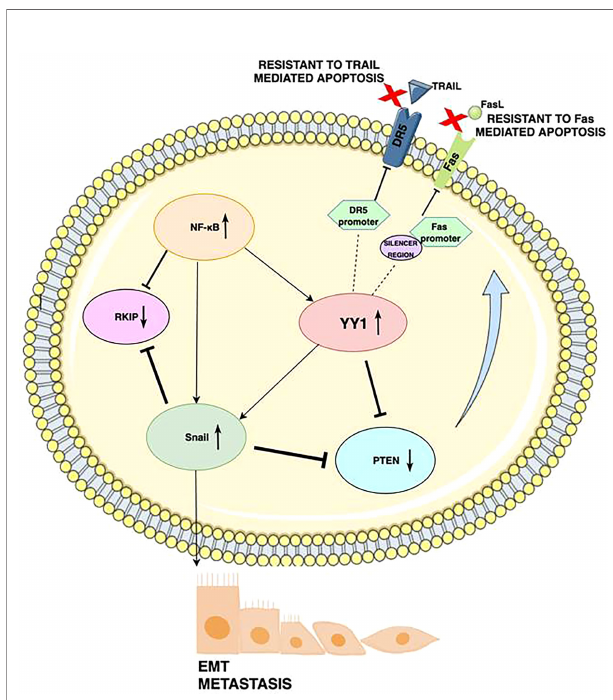
FIGURE 2 | Schematic diagram illustrating the mechanism by which YY1 regulates drug resistance in cancers: Activation of the YY1 negatively regulates DR5 transcription by binding to the DR5 promoter region, which elicits resistance to TRAIL-induced apoptosis. YY1 binds to the silencer region of the Fas promoter, blocks Fas expression and further leads to downregulation of Fas expression and resistance of cancerous cells to Fas- mediated apoptosis. High NF-kB expression corresponds to low RKIP expression, as well as NF-kB induces YY1 expression, which then represses PTEN. The underexpression of Fas is also caused by NF- k B ’ s activation of YY1. YY1 induces SNAIL, the repressor of RKIP. Expression of YY1 and Snail is participating in downregulation of PTEN and DR5. As a result, YY1 promotes epithelial to mesenchymal transition (EMT) and metastasis through upregulation of